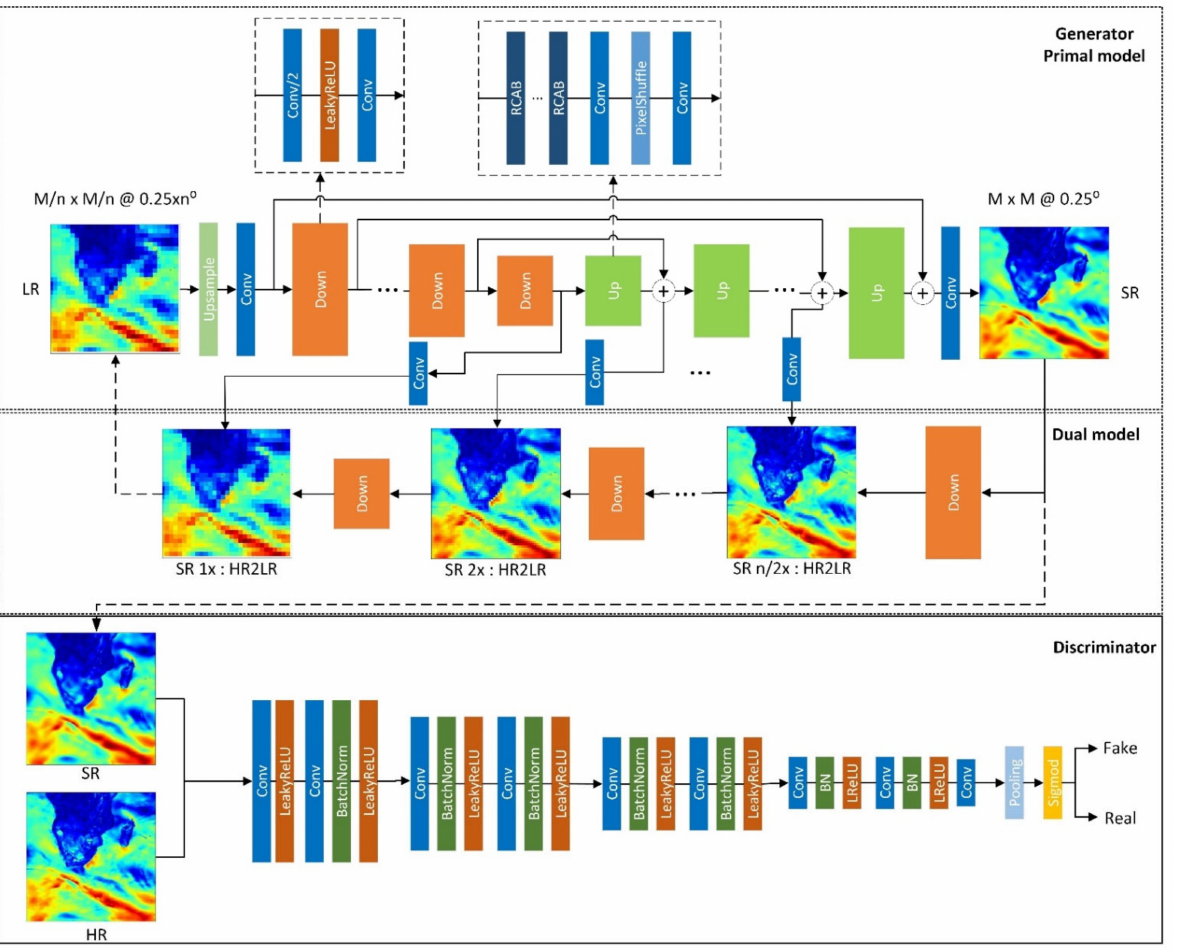
Figure 4. The sea surface wind downscaling network based on generative adversarial network structure and dual